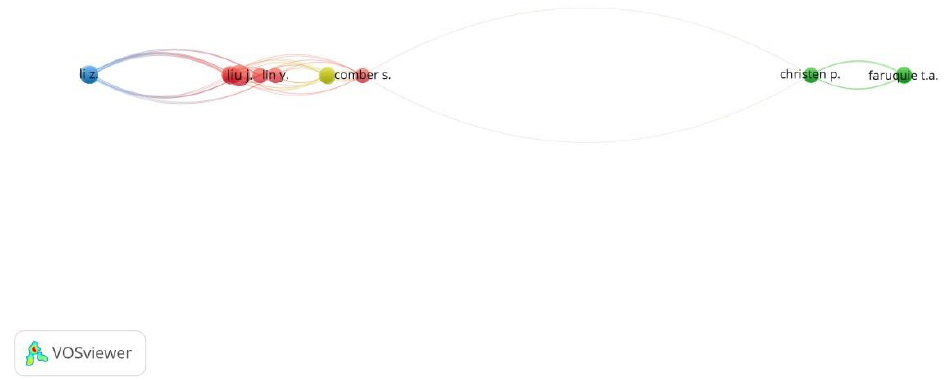
Figure 6. Author bibliographic coupling visualization network. Note: Each circle represents an author, with larger circles representing researchers that have more publications. The relative strength of the relations between authors is represented by the color of the clusters and by how close they are to each other on the visualization.